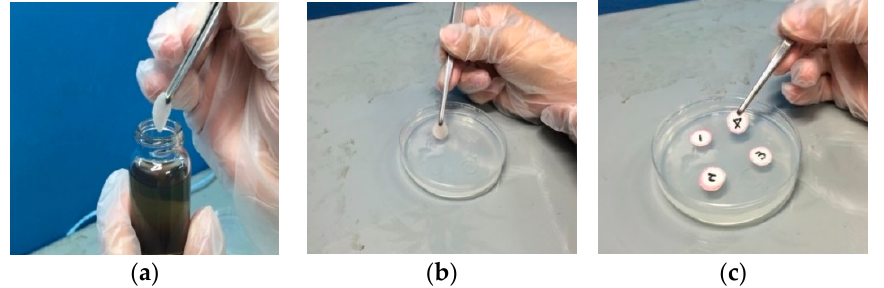
Figure 5. Pictures of cotton pad test process: ( a ) 140 mm labeled cotton pad soaked in NO.1~NO.4 test solutions; ( b ) cotton pad carefully placed in culture medium with tweezers; ( c ) the aforesaid steps repeated four times.